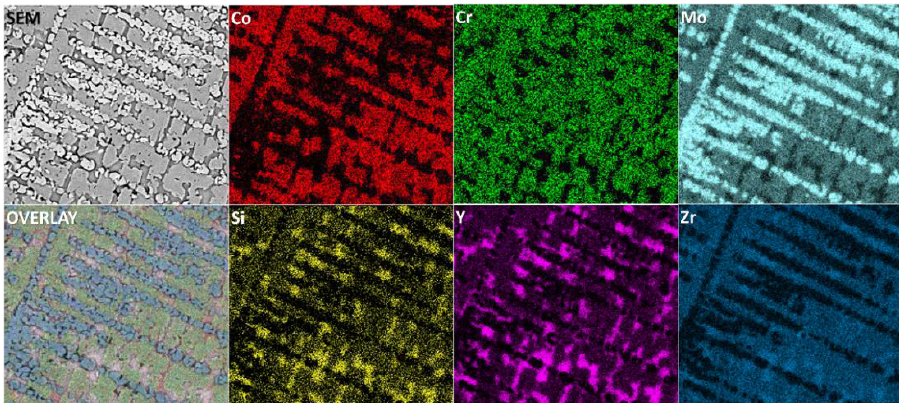
Figure 3. SEM energy-dispersive X-ray spectroscopy (EDS) elemental distribution maps in the studied alloy.